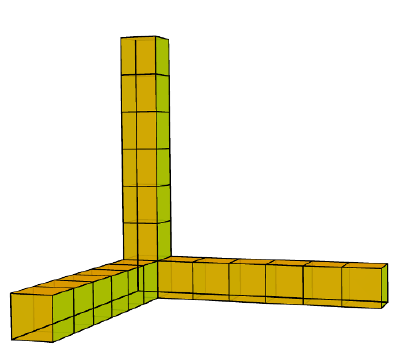
Figure 18. An example of the con(cid:12)guration of boxes representing a highest weight state with three non-trivial asymptotics, ( (cid:3) ; (cid:3) ; (cid:3) ). There is one box shared by all three piles of boxes which contributes a (cid:0) 2 shift of the conformal dimension of this representation. This (cid:12)gure is taken from